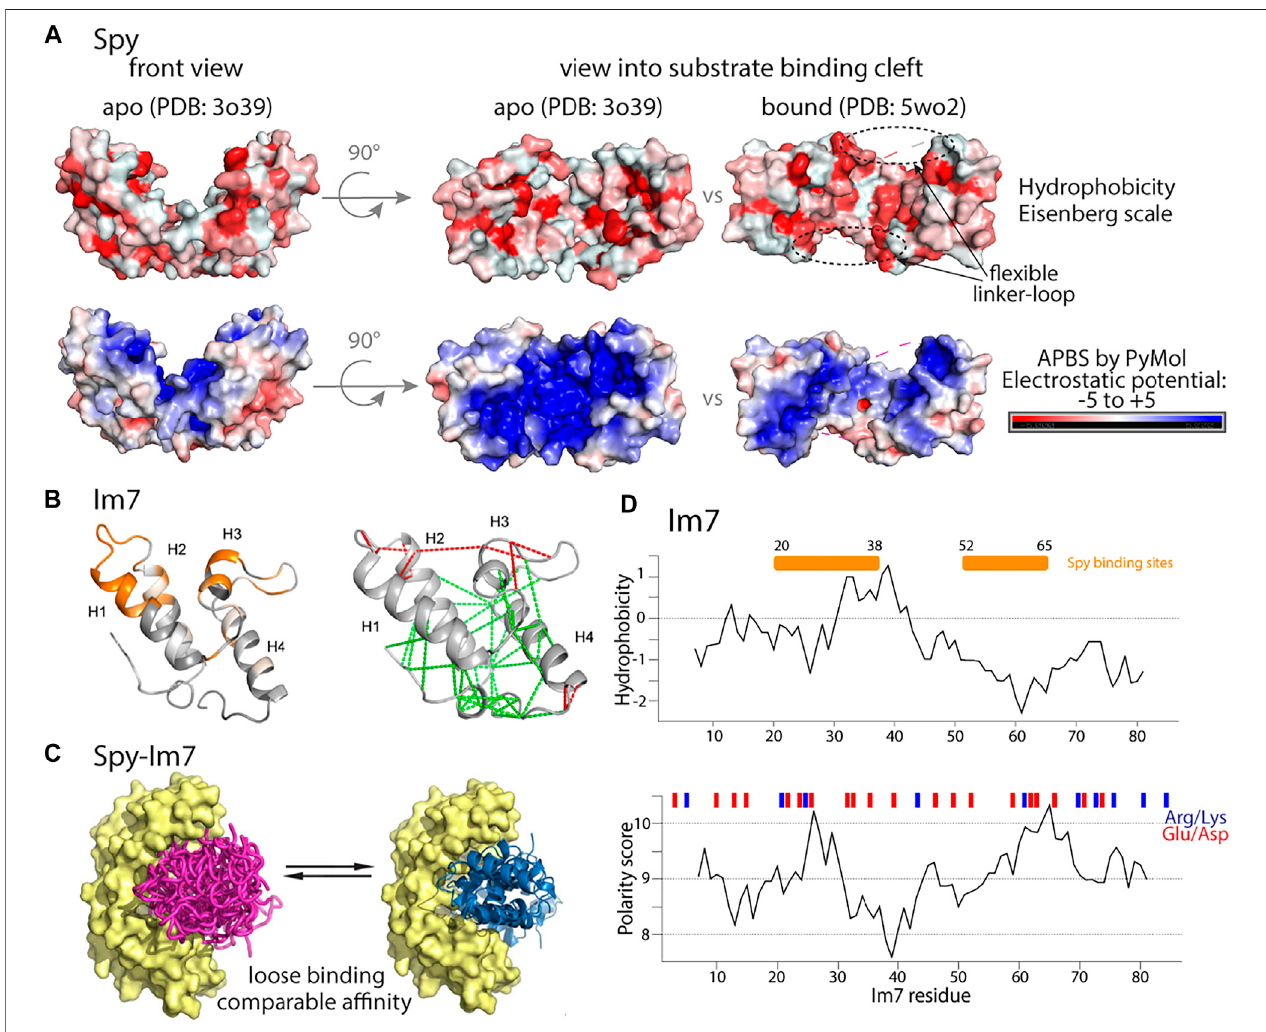
FIGURE5| PropertiesofperiplasmicchaperoneSpyanditssubstrateIm7. (A) Hydrophobicity (upper) andelectrostaticpotential (lower) oftheSpychaperonein itsapoorpeptide-boundconformationshowdistinctpatterns. (B) ChemicalshiftperturbationsmappedonthestructureofIm7(PDB:1AYI)uponaddingSpychaperone Heetal.(2016)areshownintheleftpanel.Intherightpanel,structurallyfrustratedcontacts(redlines)mappedontheIm7structure.FigureadaptedfromHeetal.(2016). (C) Representation of chaperone Spy (in yellow) bound to ensemble state ofunfolded Im7 (purple) or to folded Im7 (blue). Figure adapted from He et al. (2016). (D) Upper:HydrophobicitypredictionofthefulllengthIm7clientprotein(Kyte-Doolittlescale).Lower:Polarityprediction(Granthamscale).Redandbluebarsdenoteposition ofnegativelyandpositivelychargedresidues.TheSpybindingsiteHeetal.(2016)isshownwithanorangebar. Figure5B,C hasbeenadaptedfromHeetal.(2016)with permission from Science Advances.